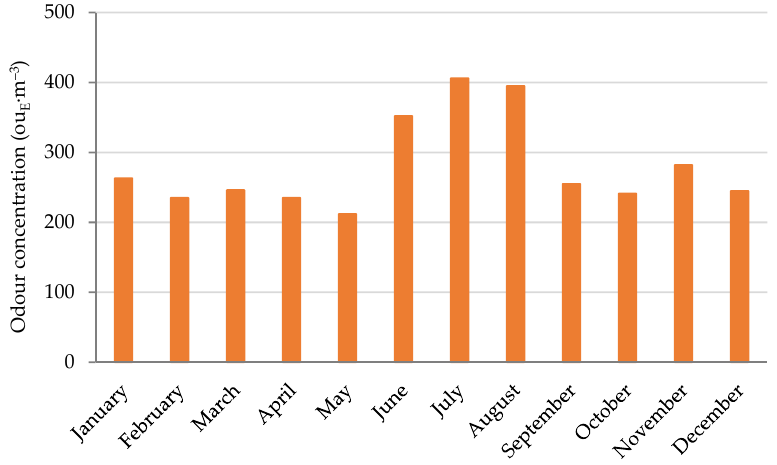
Figure 7. Mean odour concentration for breeding hens for eggs.